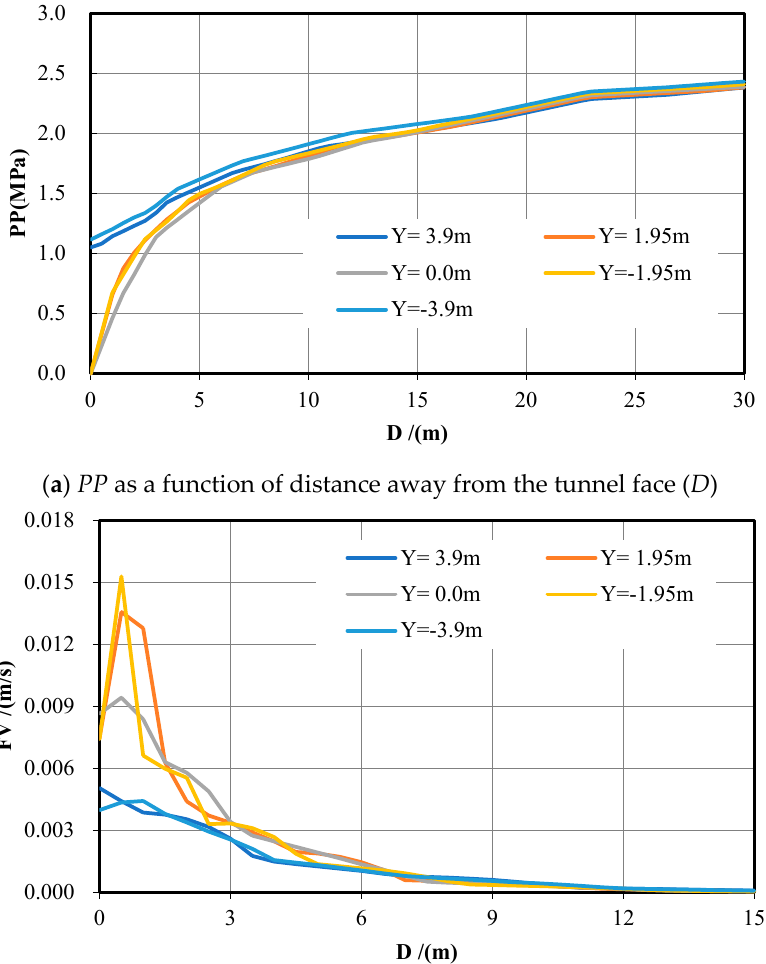
Figure 7. Pore pressure and flow velocity within 30 m ahead of the tunnel face as a function of distance away from the tunnel face (Y = 0 m).